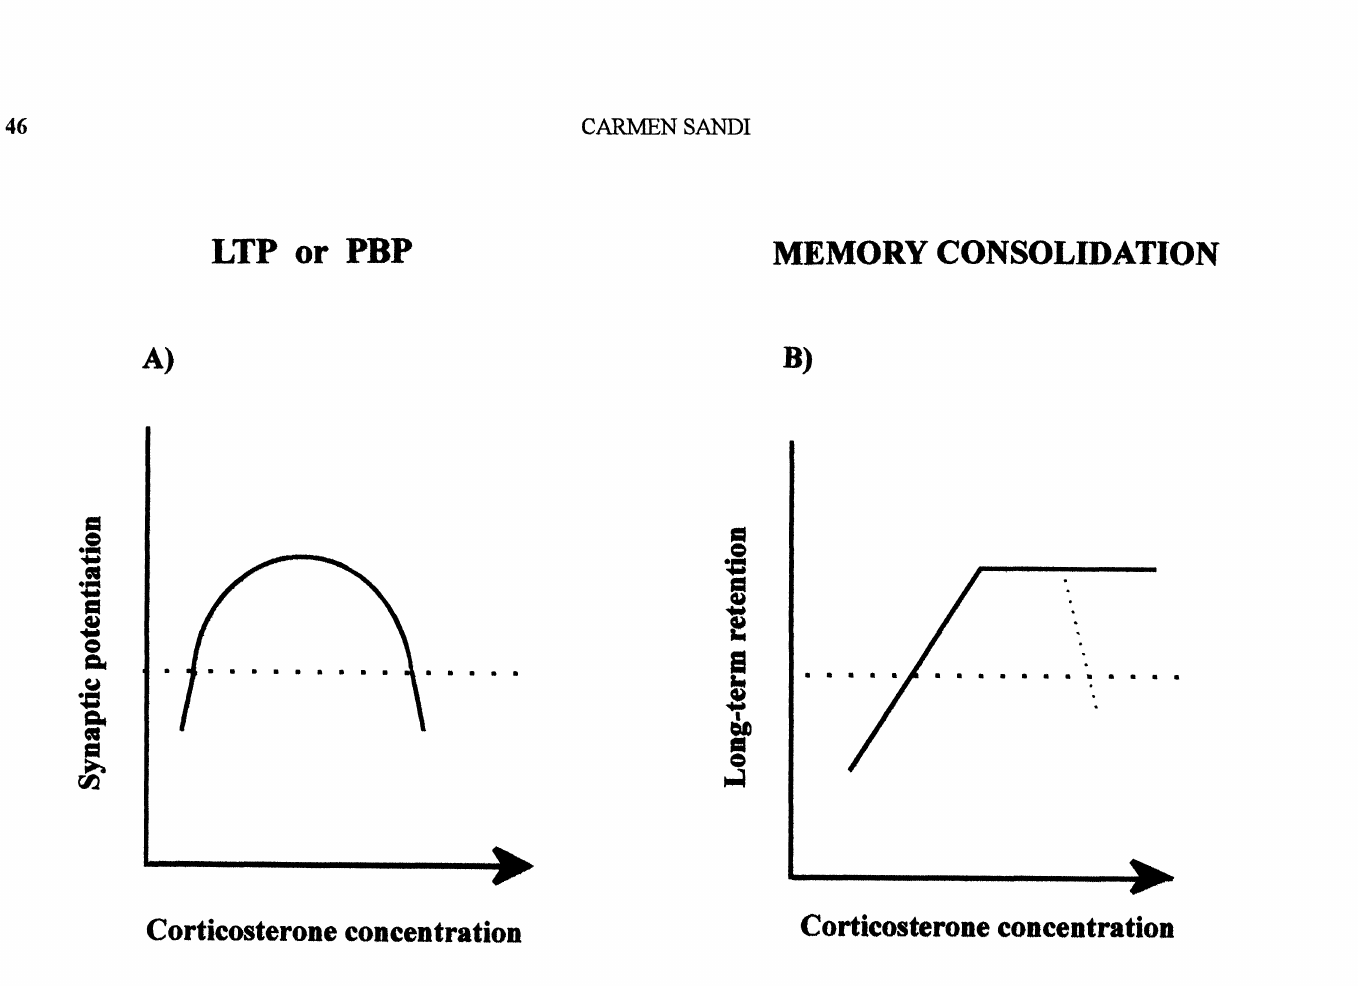
Fig. 2: Cartoon comparing the effects of circulating conico-stemne levels on (A) the establishmem of synaptic potentiation in two models of hippocampal plasticity, long-term potemiation (LTP), and primed burst potenti-ation (PBP), which reportedly follows an inverted U-shaped function; 03) long-term retention of newly acquired information, according to our hypothetical model implicating corticosterone levels in the neural mechanism that determine the strength at which information is stored into long-term